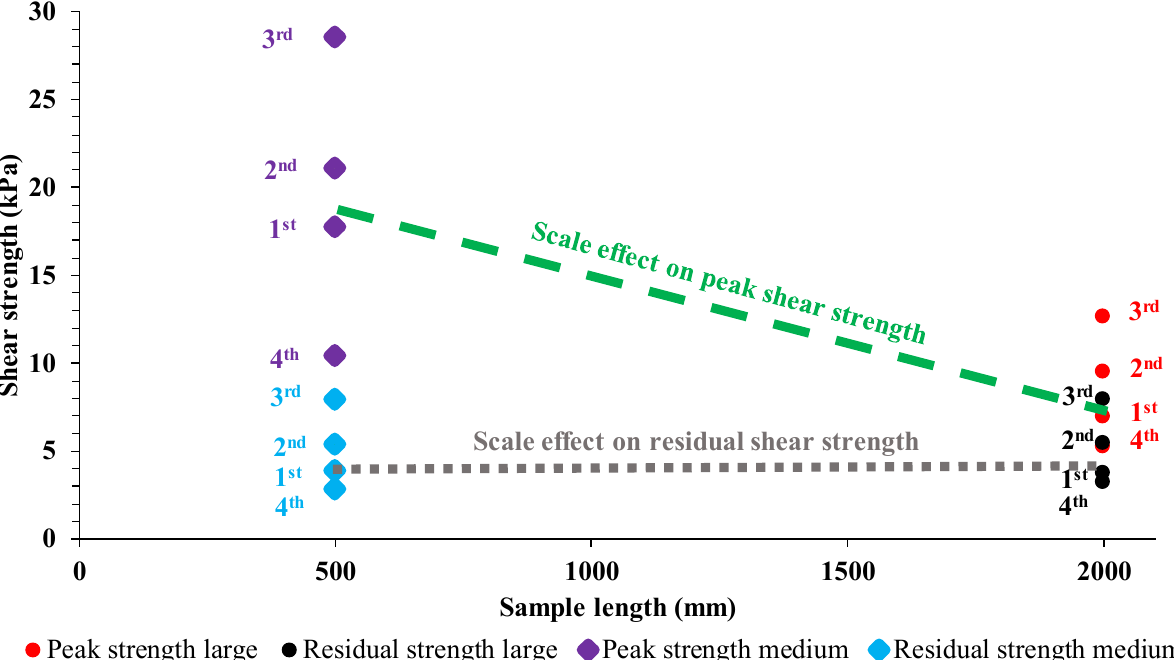
Figure 15. Peak and residual shear strength at different loading stages and scales.